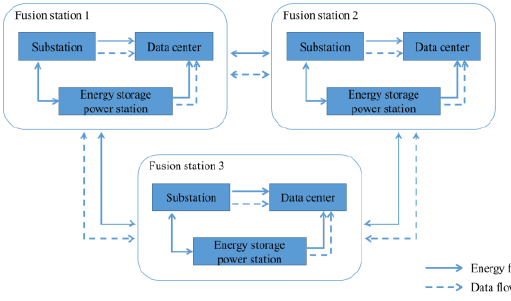
Fig. 1. Example of such fusion